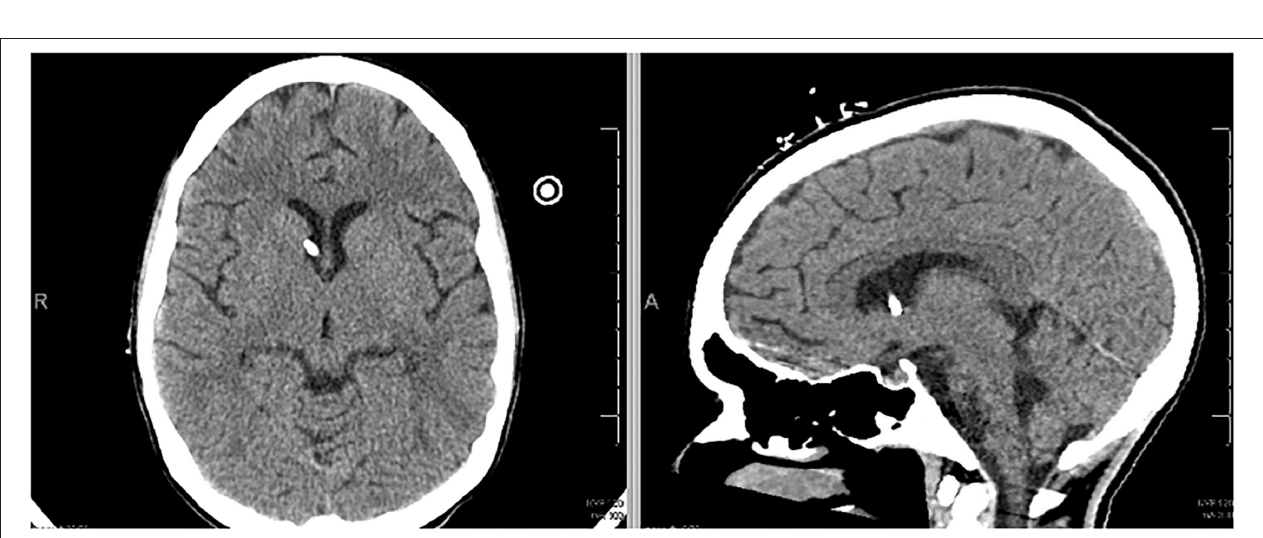
FIGURE 4 | Non-contrast CT scan demonstrating improved cerebral edema on day of EVD